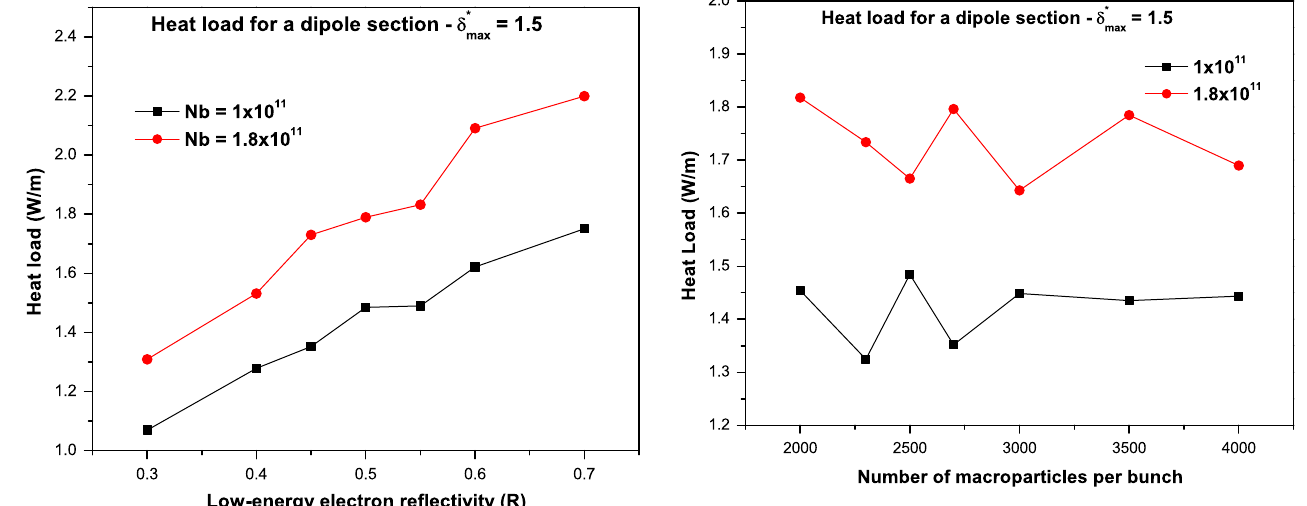
FIG. 16. Simulated heat load for a dipole section as a function of R for two different bunch intensities, and (cid:1) (cid:3) max ¼ 1 : 5 .